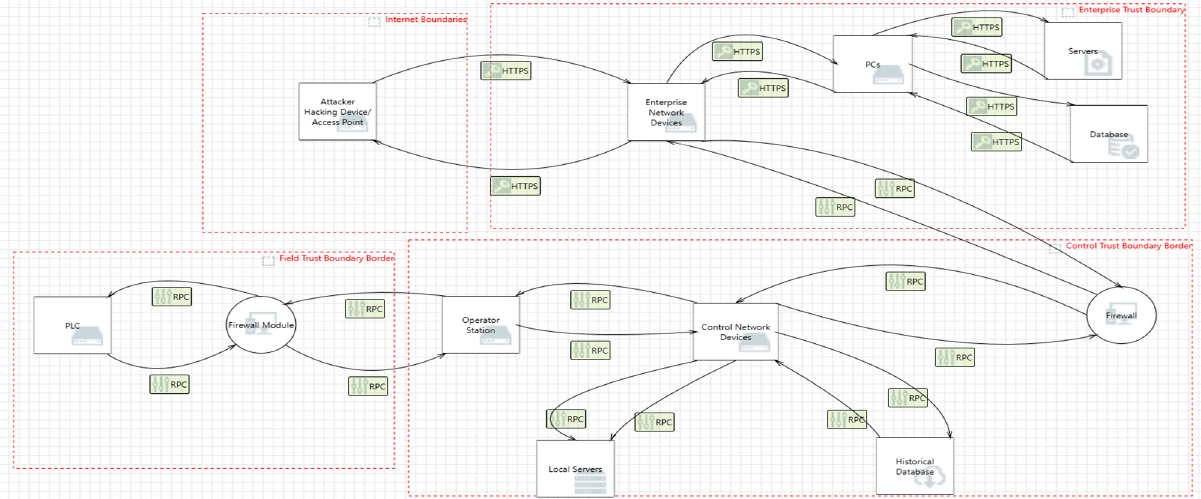
Figure 6 . The WTP system architecture, utilizing the Microsoft Threat Modeling Tool (MTMT).